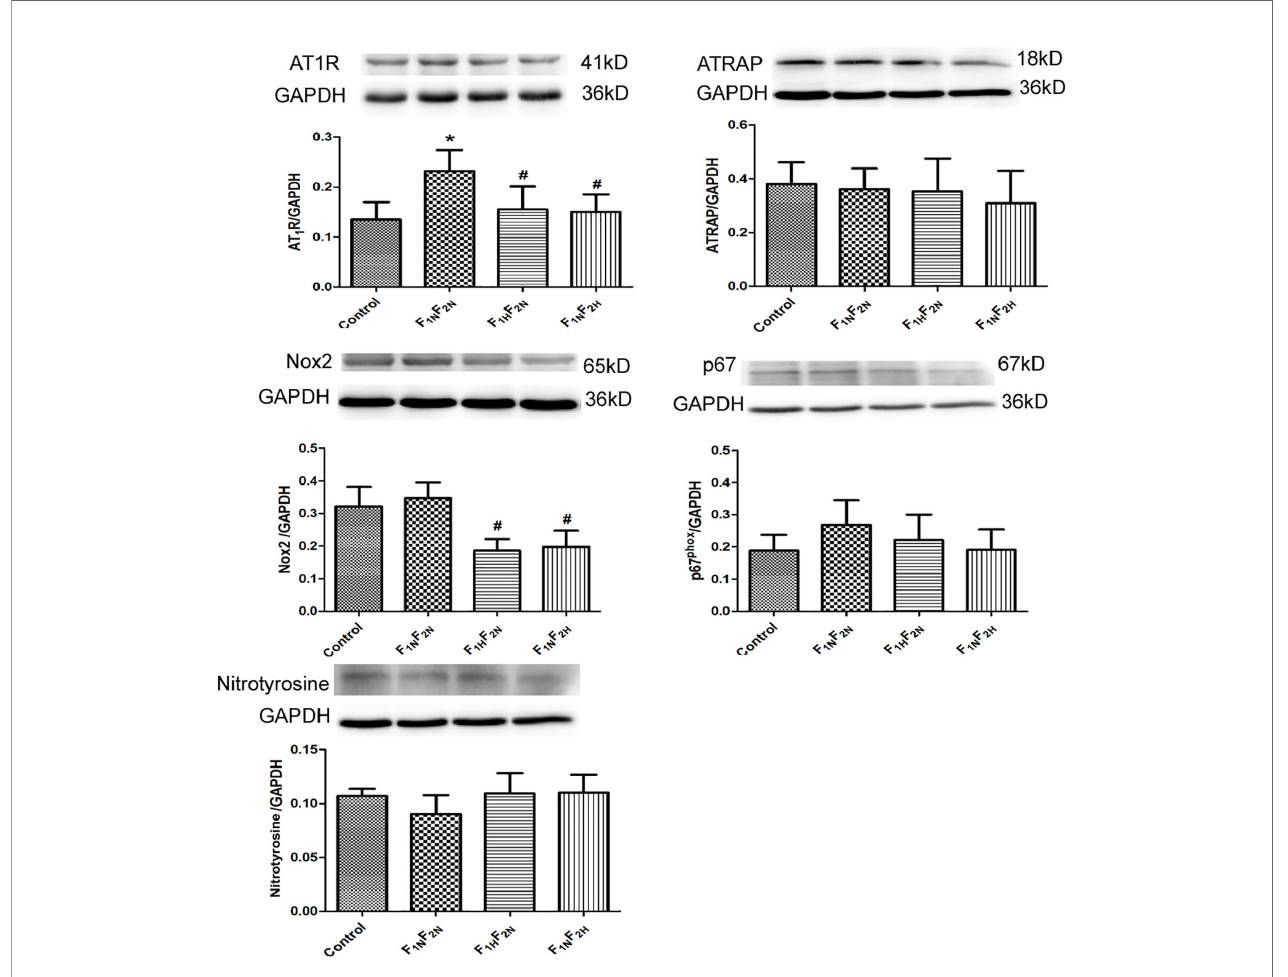
FIGURE 6 | Western blot analysis of protein expression of AT1R, ATRAP, Nox2, p67phox, and nitrotyrosine in NTS in female offspring from the control, F 1N F 2N (offspring of RVH rats), F 1H F 2N (RVH rats treated with NaHS, offspring without NaHS), and F 1N F 2H (maternal RVH rats treated without NaHS and offspring with NaHS after weaning) groups. Data are mean ± SE ( n = 12). * P < 0.05 compared with control and # P < 0.05 compared with F 1N F 2N . GAPDH was used to